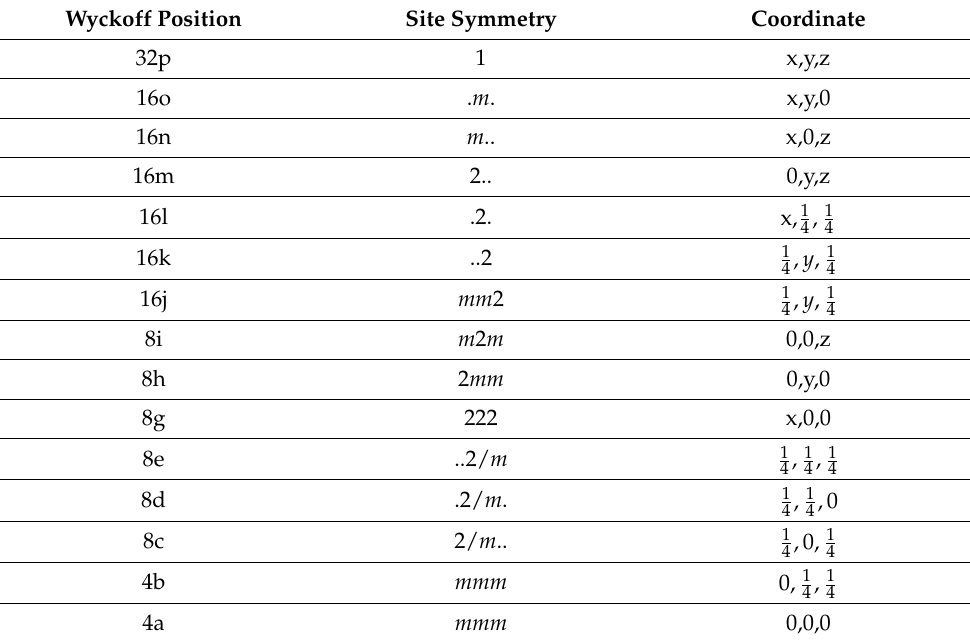
Table 3. Wyckoff positions with site symmetry and their coordinates.